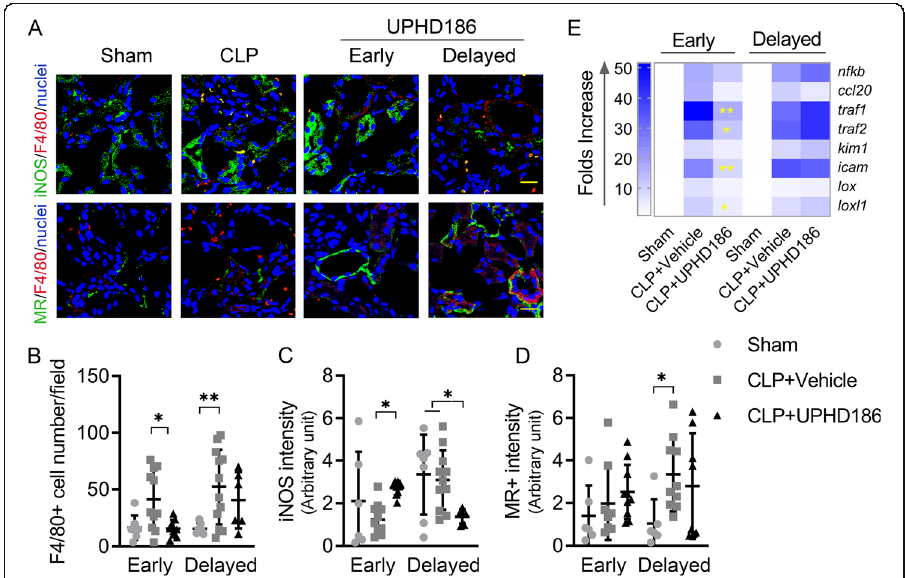
Fig. 3 Short-term effect. Treatment effects measured at treatment day 3. a Representative images of immune staining of markers of mononuclear cells and their phenotype. Scale bar = 20 μ m. b – d Dot plots of F4/80 + MNC cell numbers per field, the stain intensities of iNOS + and MR + colocalized with F4/80 + for group animals (mean ± SD, N = 7~12). Tukey ’ s test was used to determine statistical significance. e Heat map of renal mRNA expressions of inflammation and matrix remodeling mediator markers ( N = 6~8). * P < 0.05, ** P < 0.01 compared to the CLP + vehicle group. iNOS, inducible nitric oxide synthases; F4/80, also known as EMR1, EGF-like module-containing mucin-like hormone receptor-like 1; MR, mannose receptor; nfkb , nuclear factor kappa B; ccl10 , C-C Motif Chemokine Ligand 20; icam , intercellular adhesion molecule; traf , tumor necrosis factor receptor-associated factor; kim1 , also known as HAVCR1 , hepatitis A virus cellular receptor 1; lox , lysyl oxidase; loxl1 , lysyl oxidase homolog